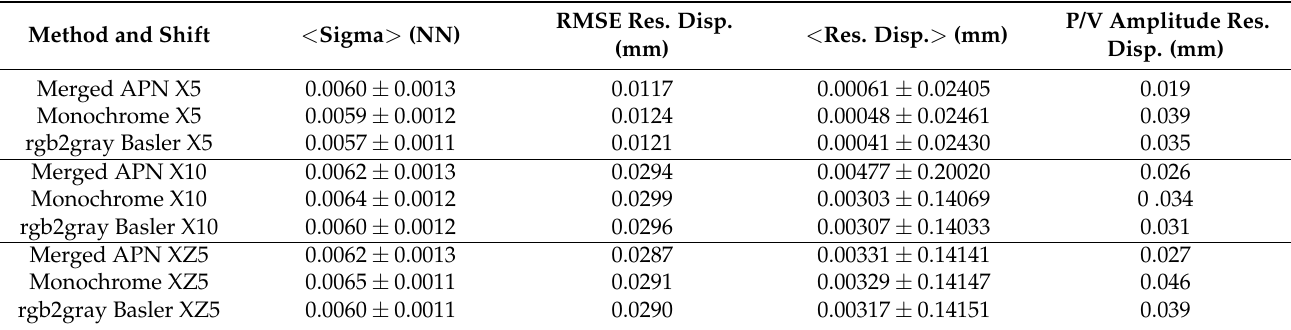
Table 3. Demosaicking evaluation for Flower .